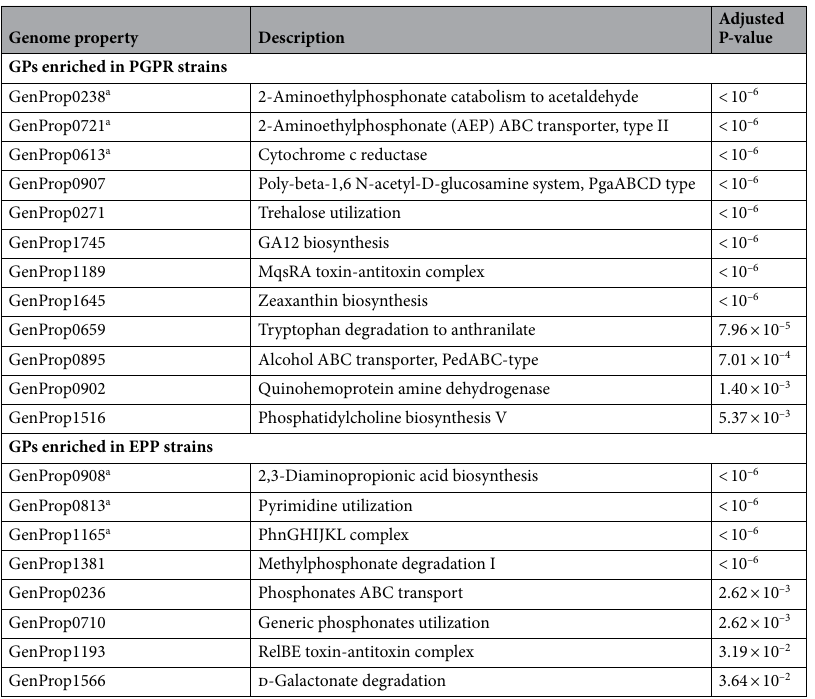
Table 2. Genome properties related to the plant-associated lifestyle: enrichment analysis. a These Genome Properties are also important random forest features (Table